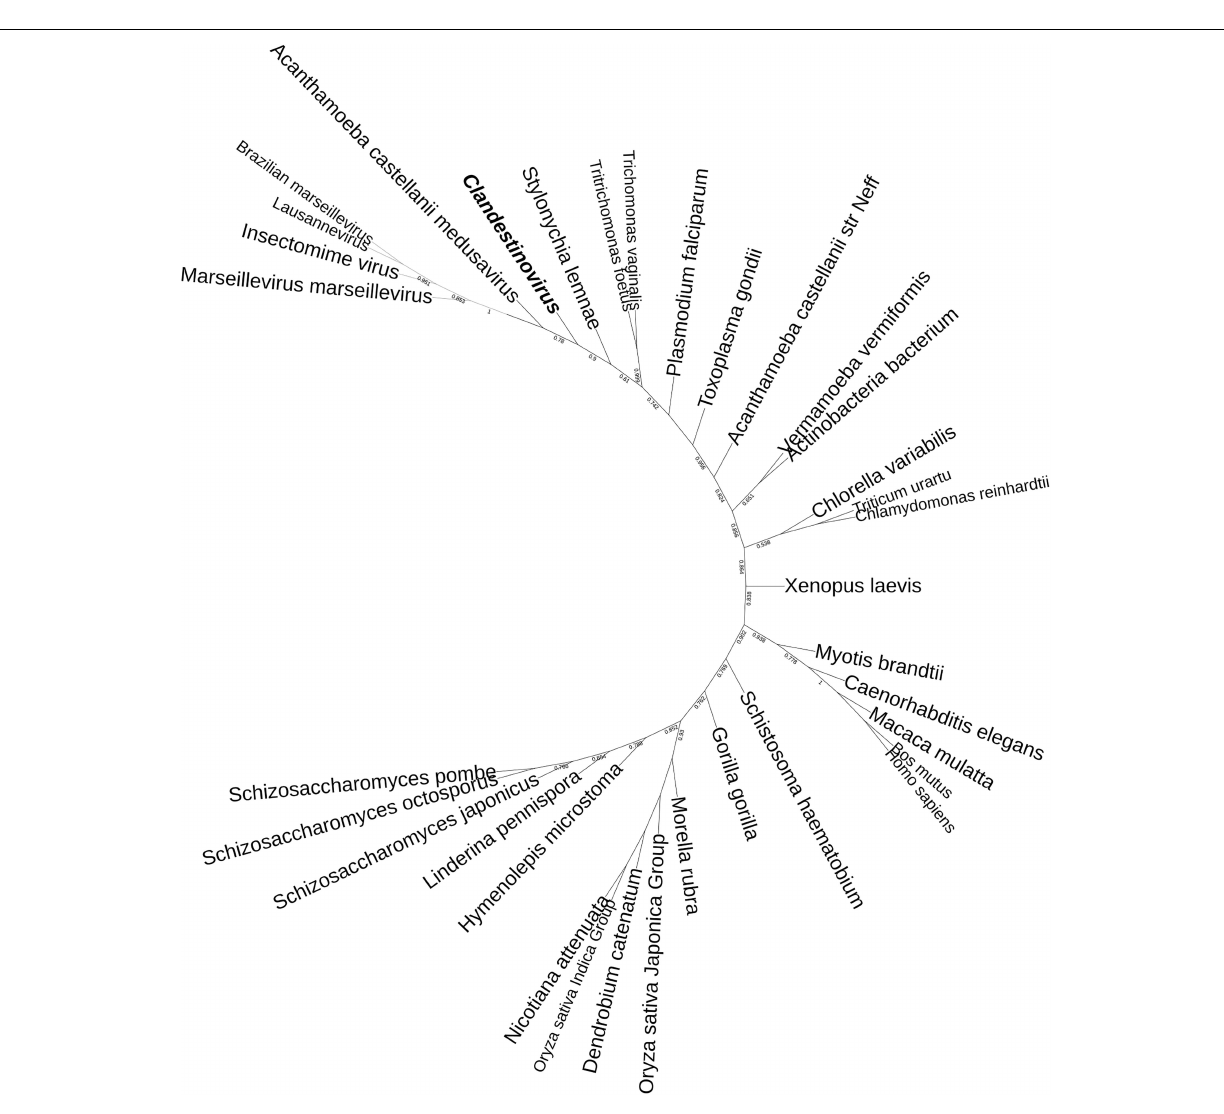
FIGURE 5 | Phylogenetic tree of the histone H3 of clandestinovirus. The analysis was performed using the ML method with a Jones-Taylor-Thornton (JTT) substitution matrix and 1,000 replicates. Branches with bootstrap support values below 0.50 were collapsed. Clandestinovirus is highlighted in bold and